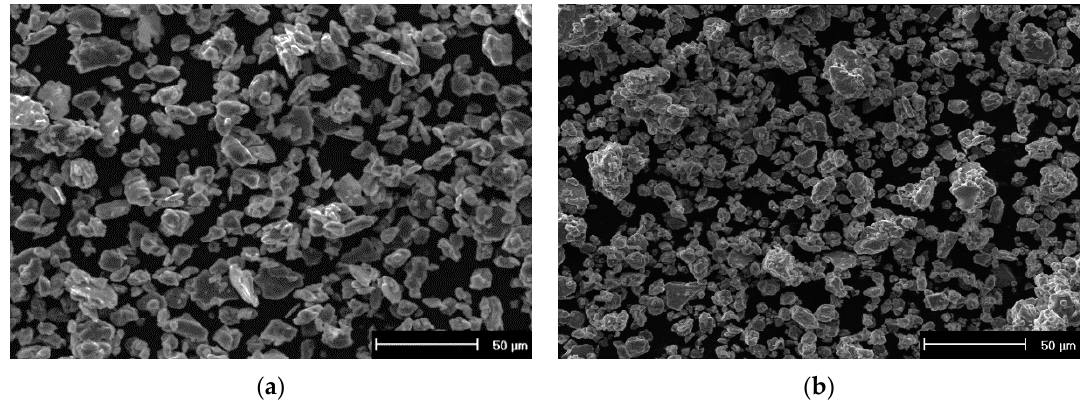
Figure 2. SE ‐ SEM micrographs of ( a ) V and ( b ) A powders.